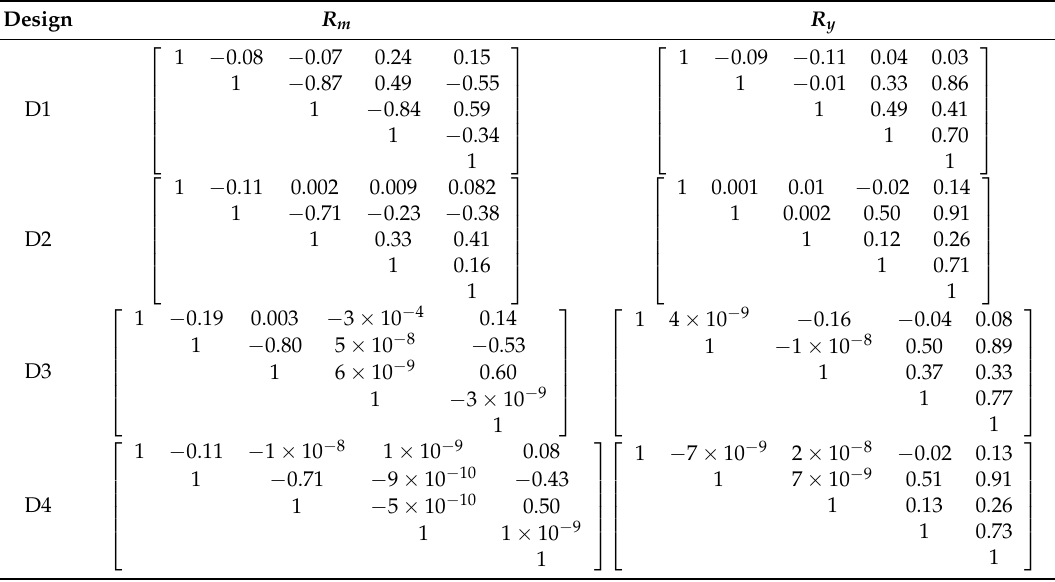
Table 8. Input and output correlations matrices for designs D1–D4 for a 5 × 5 FCC unit.